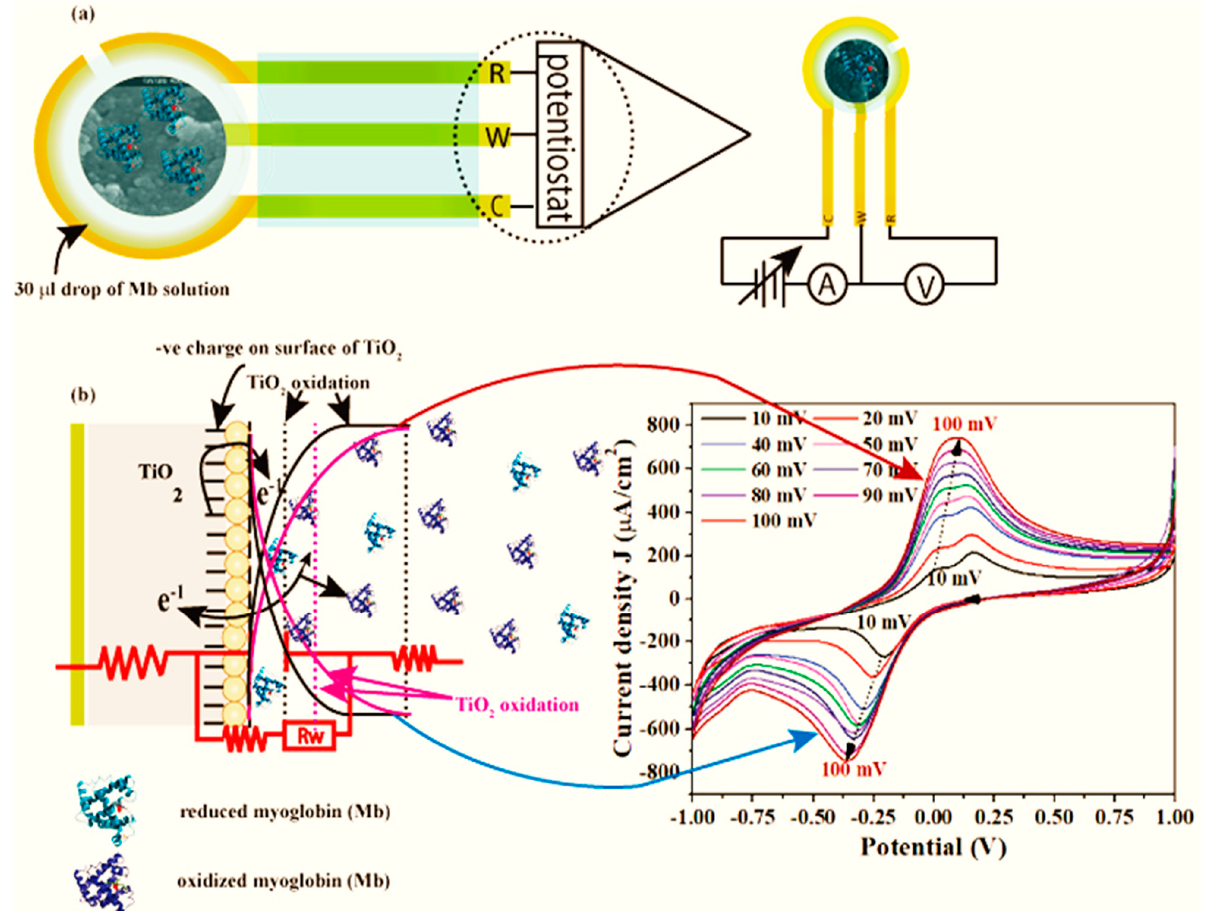
Figure 8. ( a ) Fabrication of Mb biosensor based on pure and Cu-doped TiO 2 nanomaterials, and ( b ) Mb sensing mechanism. ( b ) Mb sensing